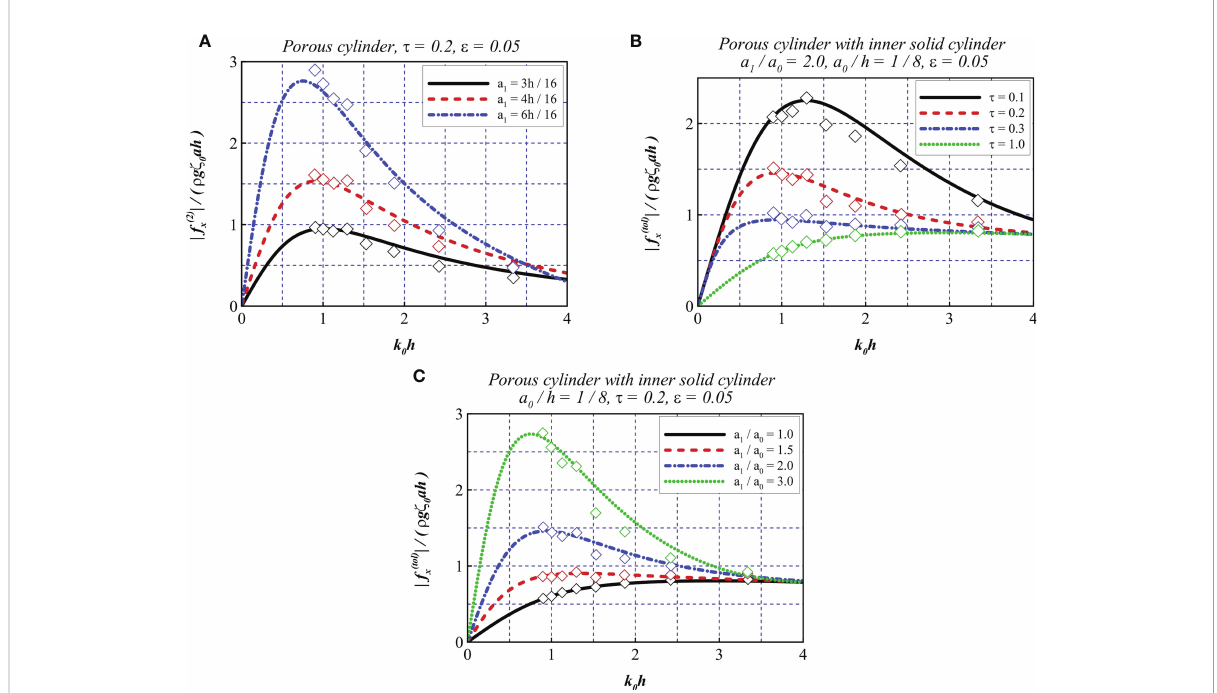
FIGURE 7 Comparison of non-dimensional horizontal force from the numerical model (solid line) and experimental data (diamonds). (A) Wave loads on a porous cylinder. (B, C) Wave loads on a porous cylinder with inner solid